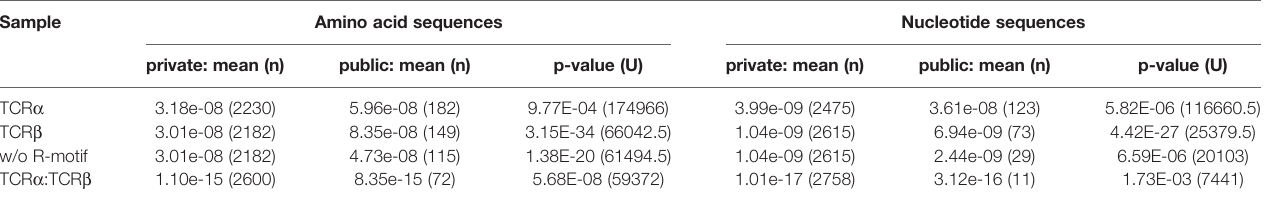
TABLE 3 | The mean IRGP values for public and private sequences, with the number of sequences given in parentheses. Sample Amino acid sequences Nucleotide